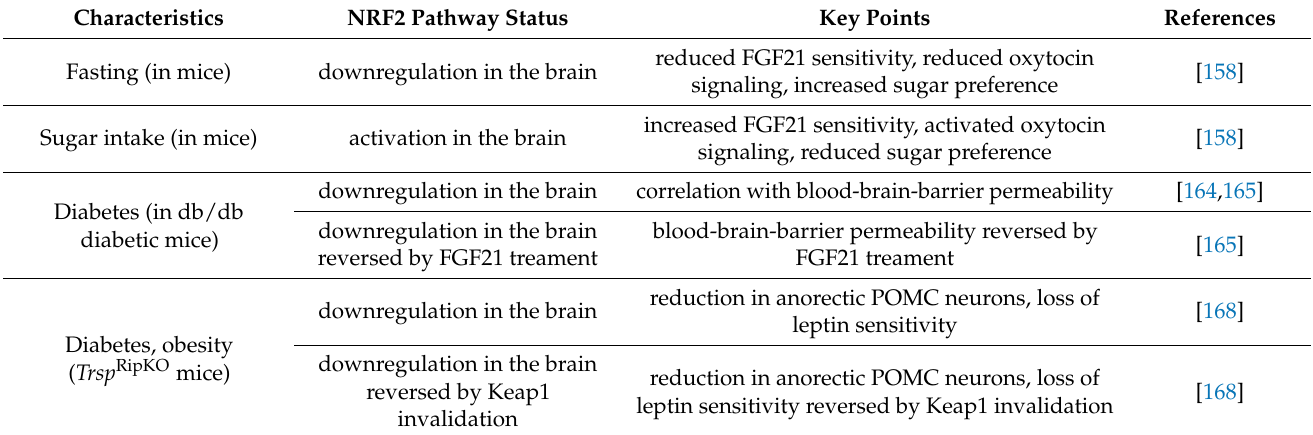
Table 2. NRF2 and brain control of energy